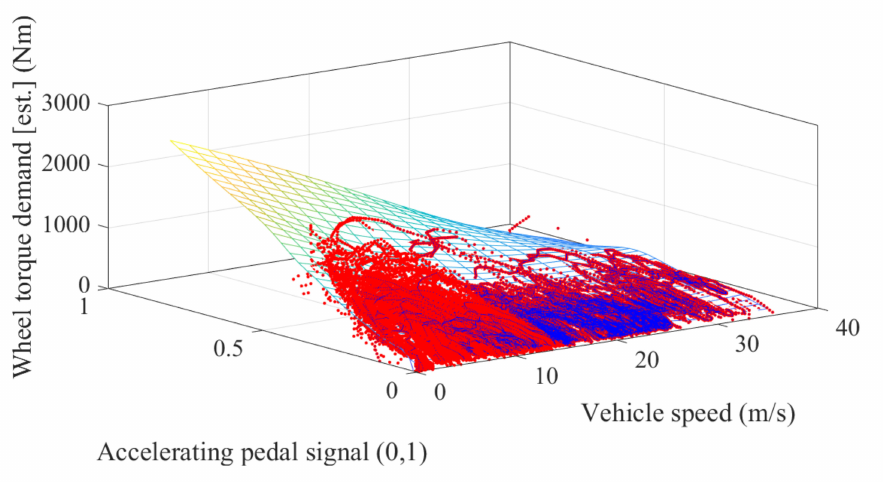
Figure 6. Estimated Wheel Demand Torque Map.